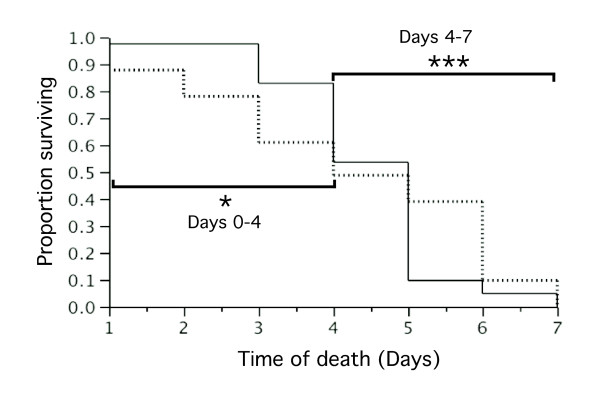
Survival of An. gambiae females with constant daily access to water (solid line) or access to water restricted to 16 h per day (dashed line) during the 7-day hydric stress experiment. Separate statistical tests were conducted on female survival during the first (day 0 - mid-day 4) and second (mid-day 4 to day 7) halves of the experiment revealing a strong interaction between the stage of the experiment and the effect of hydric stress. Level of significance are P < 0.05 *, P < 0.005 **, P < 0.001 ***.